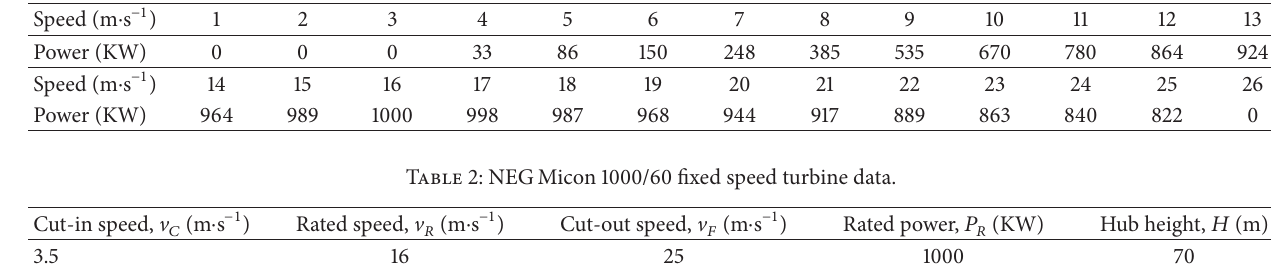
Table 1: NEG Micon 1000/60 fixed speed turbine power curve data.